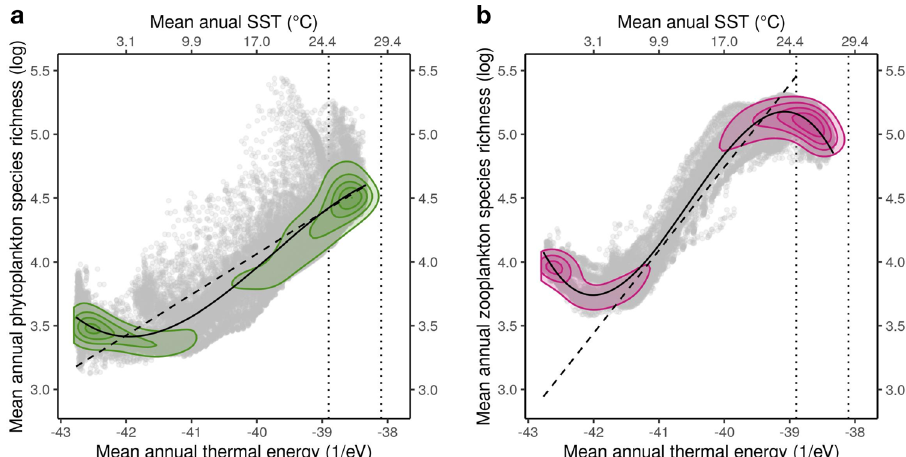
Fig. 2 Comparing the relationship between species diversity and temperature between phyto- and zooplankton. Relationships between mean annual phytoplankton ( a ) and zooplankton ( b ) species richness (log-scale) and contemporary surface temperature scaled as available thermal energy according to the framework of the metabolic theory of ecology (MTE). The natural log of species richness (SR) displays a non-linear relationship as a function of contemporary surface thermal energy, which is derived from mean annual sea surface temperature (SST, in Kelvin) and Boltzmann ’ s constant ( k ). The dashed lines illustrate the global linear relationship predicted from the slopes expected from the MTE (~0.32 for phytoplankton; ~0.65 for zooplankton). The solid curves illustrate the 3rd degree polynomial fi t that best explains the global variations of log(SR) as a function of mean annual available thermal energy. The colored isopleths illustrate the density of ocean grid cells, based on two dimensional kernel density estimates, and were used to highlight the parts of the gradients driving the observed non-linear relationships. The vertical dotted lines indicate the range of SST prevailing in the tropical band (i.e., latitudes < 30°) for the end-of-century period, according to the ensemble of earth system models forced by a RCP8.5 greenhouse gas emission